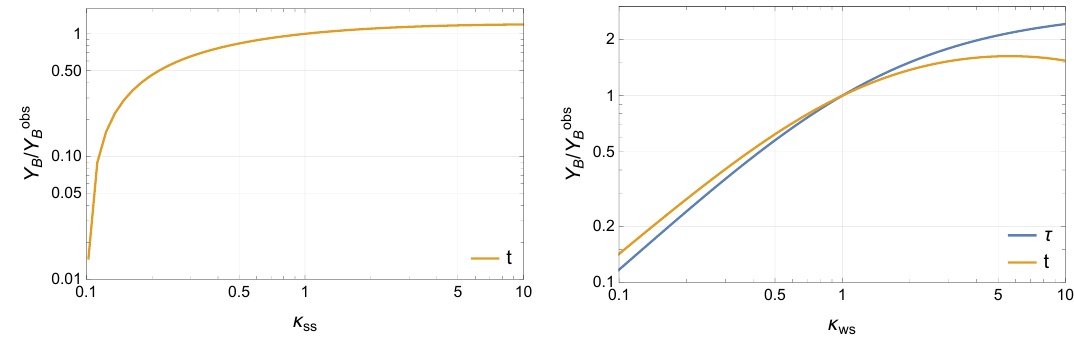
Figure 4. Y B /Y obs as a function of the strong (left) and weak (right) sphaleron rates modifier B κ ss , κ ws . For the strong sphaleron, we show only the top source, as the tau source is virtually unaffected by such